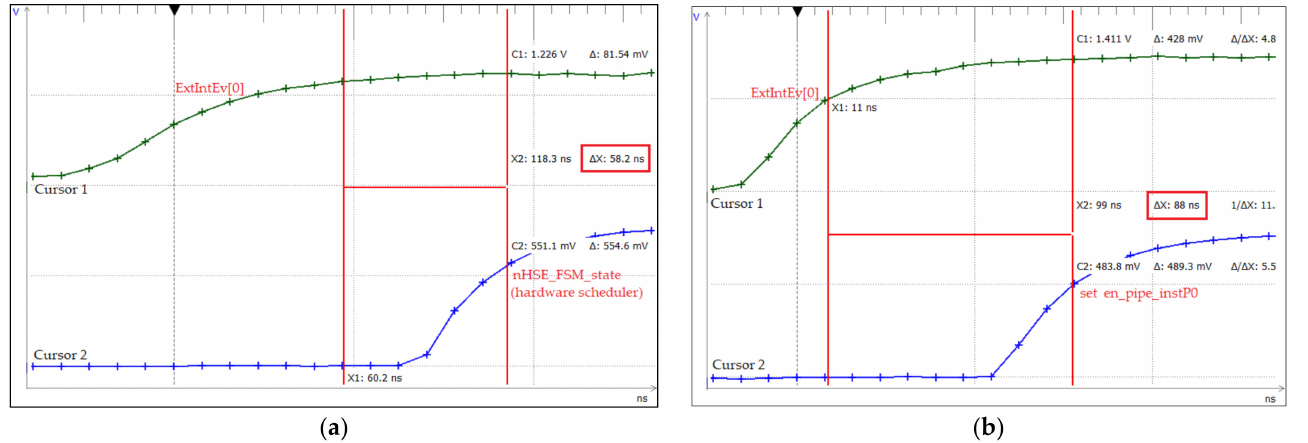
Figure 10. Kernel latency following project implementation in an FPGA: ( a ) changing the FSM state (58.2 ns); ( b ) context switch to sCPU0 (88